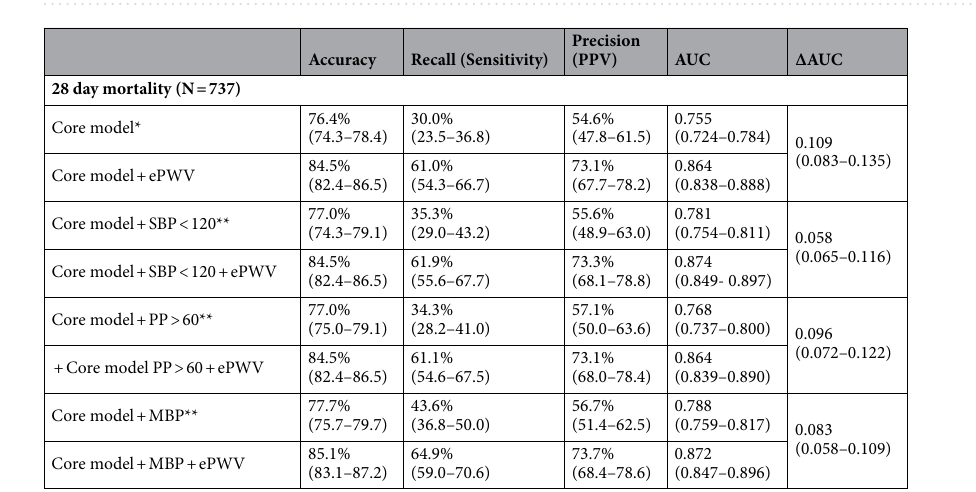
Table 2. Improvement in metrics of classification for 28-day death in COVID-19 after addition of ePWV to a core model of clinical prognostic markers and readily available blood pressure markers. The core model included age, sex, diabetes mellitus, hypertension, history of cardiovascular disease, lung disease, chronic kidney disease and active cancer. Core model additionally adjusted for MBP and MBP + ePWV aims to prove the additive prognostic value of ePWV over its constituent variables. CVD was defined as history of coronary artery disease and/or heart failure. Results based on 1,000 bootstrap replicates and derived from the test set only (20% of the total sample) after training of the boost gradient algorithm in 80% of the population (random split to training and test set). Missing values for exposure variables were imputed; thus, all patients were used for classification purposes. All comparisons to the core model (*) or the core model plus PP > 60 or SPB < 120 or MBP (**) were significant by the non-parametric Mann–Whitney test. PPV, positive predictive value; AUC, area under the curve; ePWV, estimated pulse wave velocity; SBP, systolic blood pressure; PP, pulse pressure; MBP, mean blood pressure.